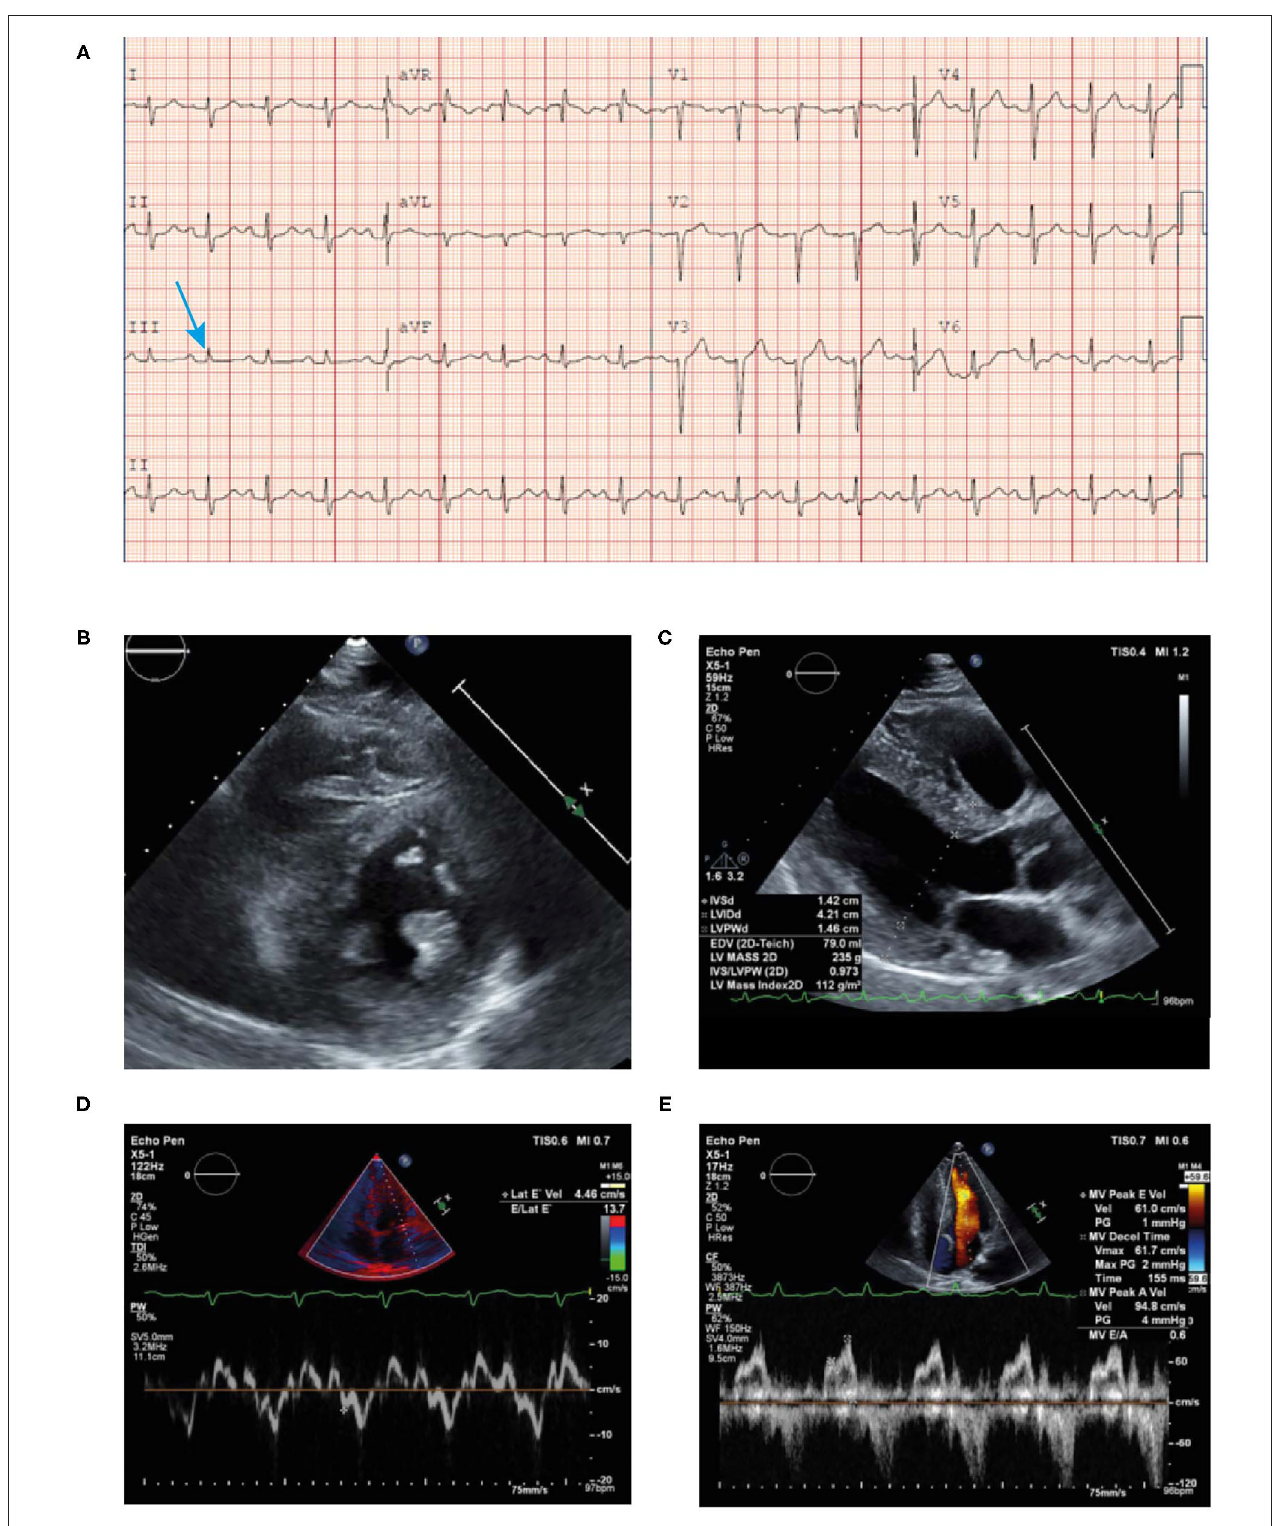
FIGURE 10 | ECG (A) showing poor R wave progression in the anterior leads and prolonged PR interval consistent with first-degree AV block (arrow). Echocardiogram (B–E) findings showing unexplained concentric LVH (1.4cm) with reduced lateral E velocity (4.46 cm/s) and mitral inflow consistent with diastolic dysfunction in the context of the ECG showing no evidence of LVH (discordance) in the absence of hypertension. ECG, electrocardiogram; LVH, left ventricular hypertrophy.